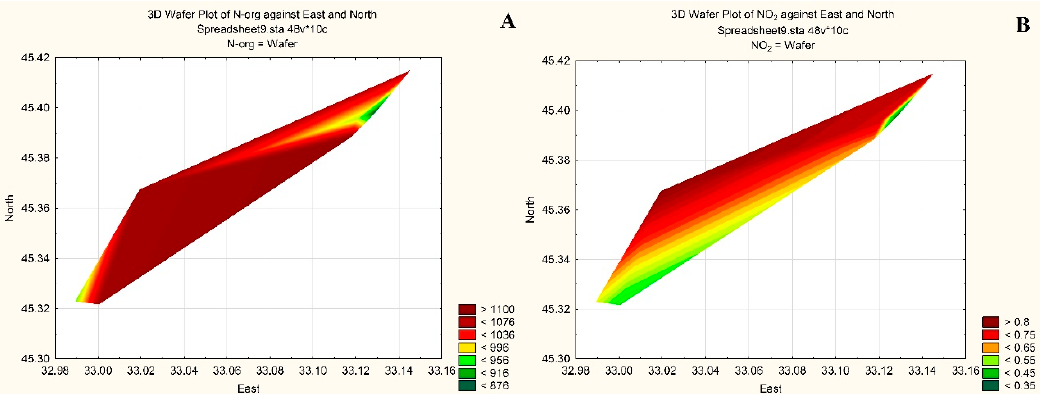
Figure 7. Average annual concentrations of organic nitrogen ( A ) and dissolved nitrites ( B ) in the water column at the sampling stations in the Donuzlav Gulf of the Black Sea.